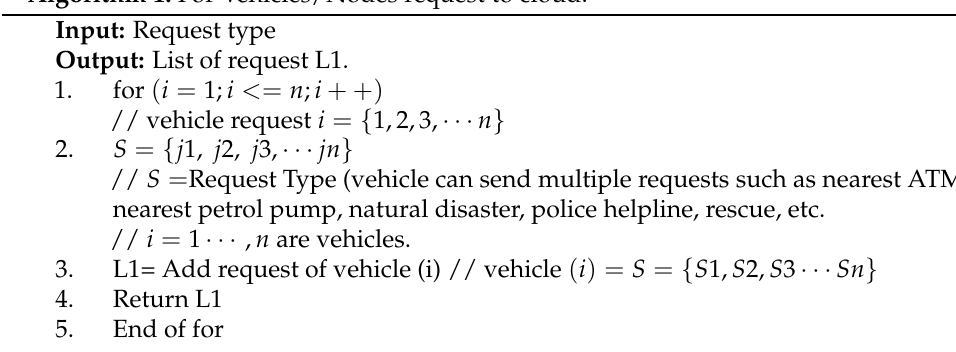
Algorithm 1: For Vehicles/Nodes request to